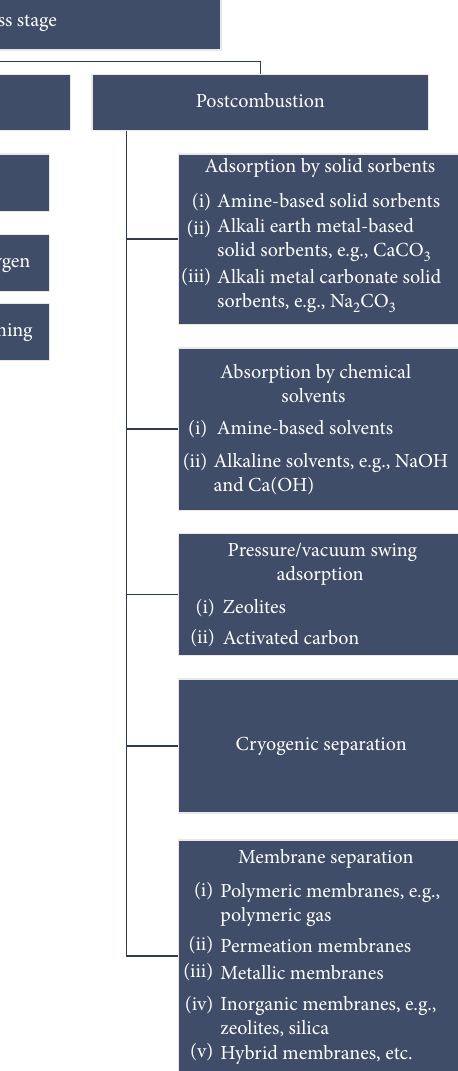
Figure 1: Carbon capture technologies by process stage.